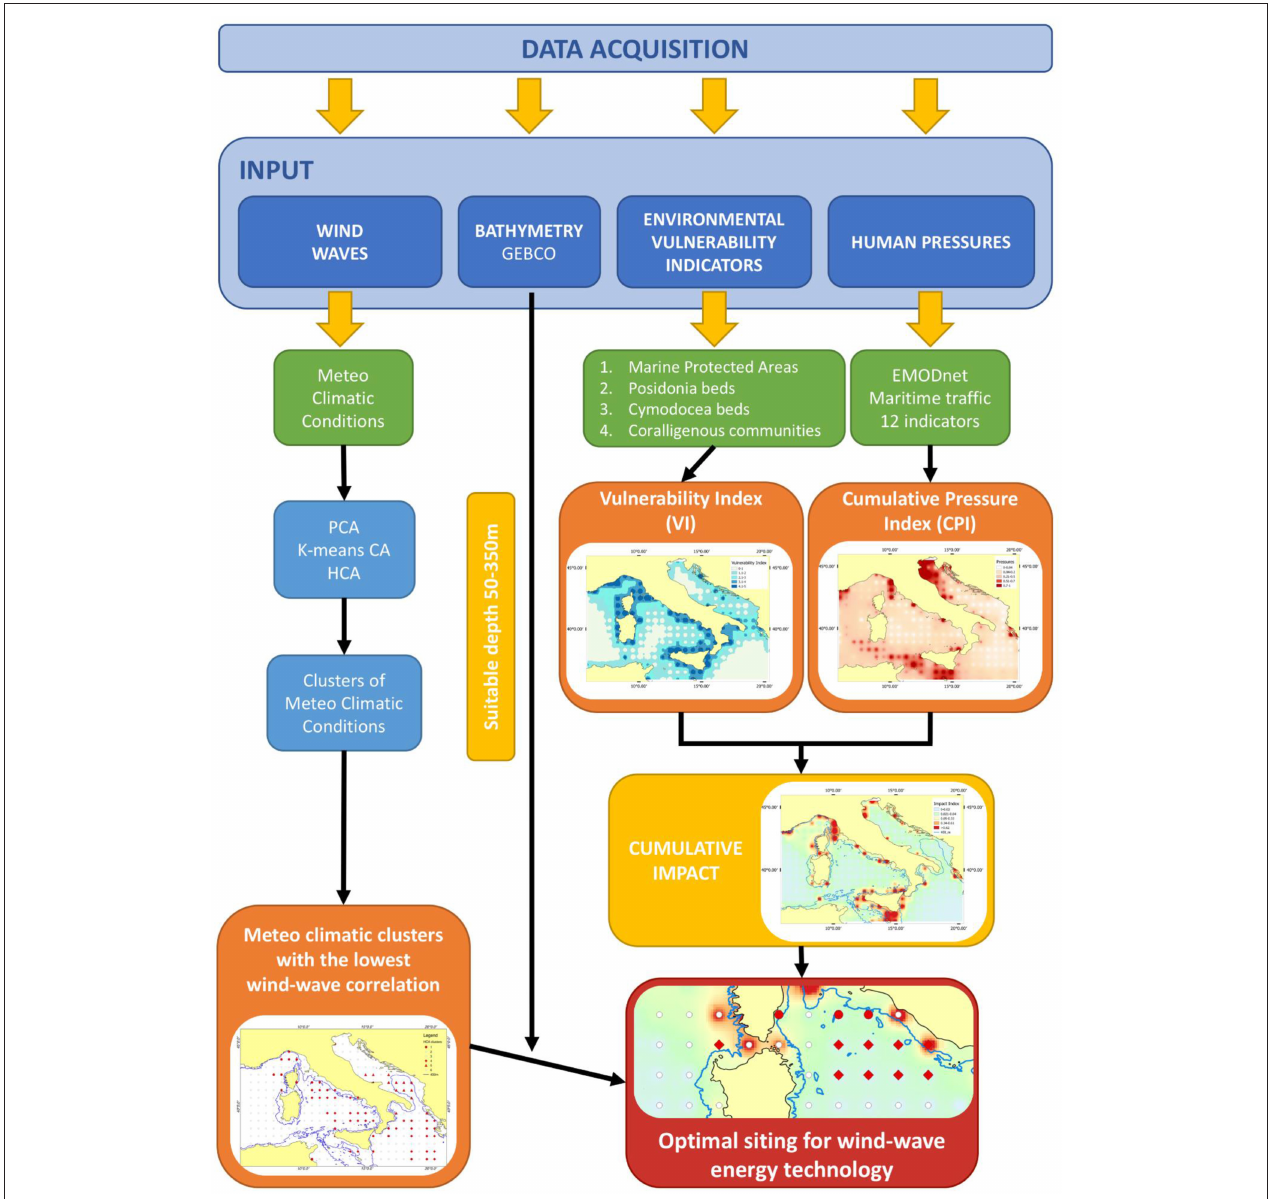
FIGURE 14 | Flow chart showing the optimal siting proposed